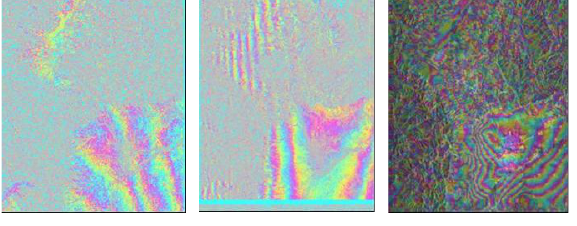
Figure 2. Displacement Map